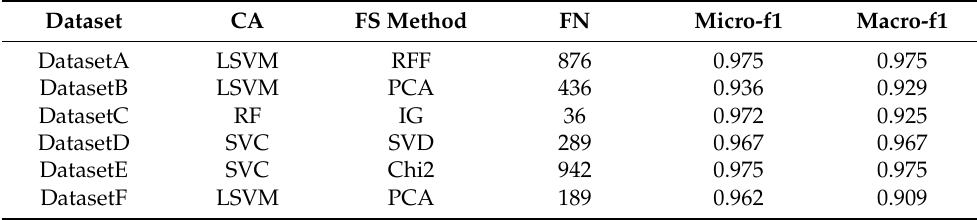
Table 4. Results of the optimal configurations obtained by OCATC.